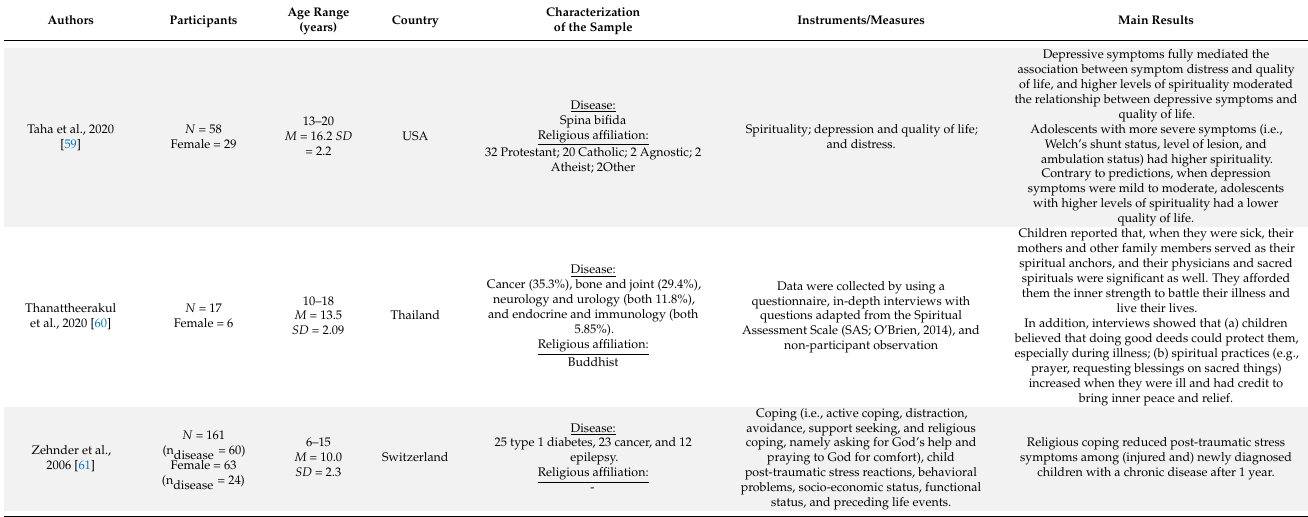
Table 1. Main characteristics and findings of the studies included in this scoping review.